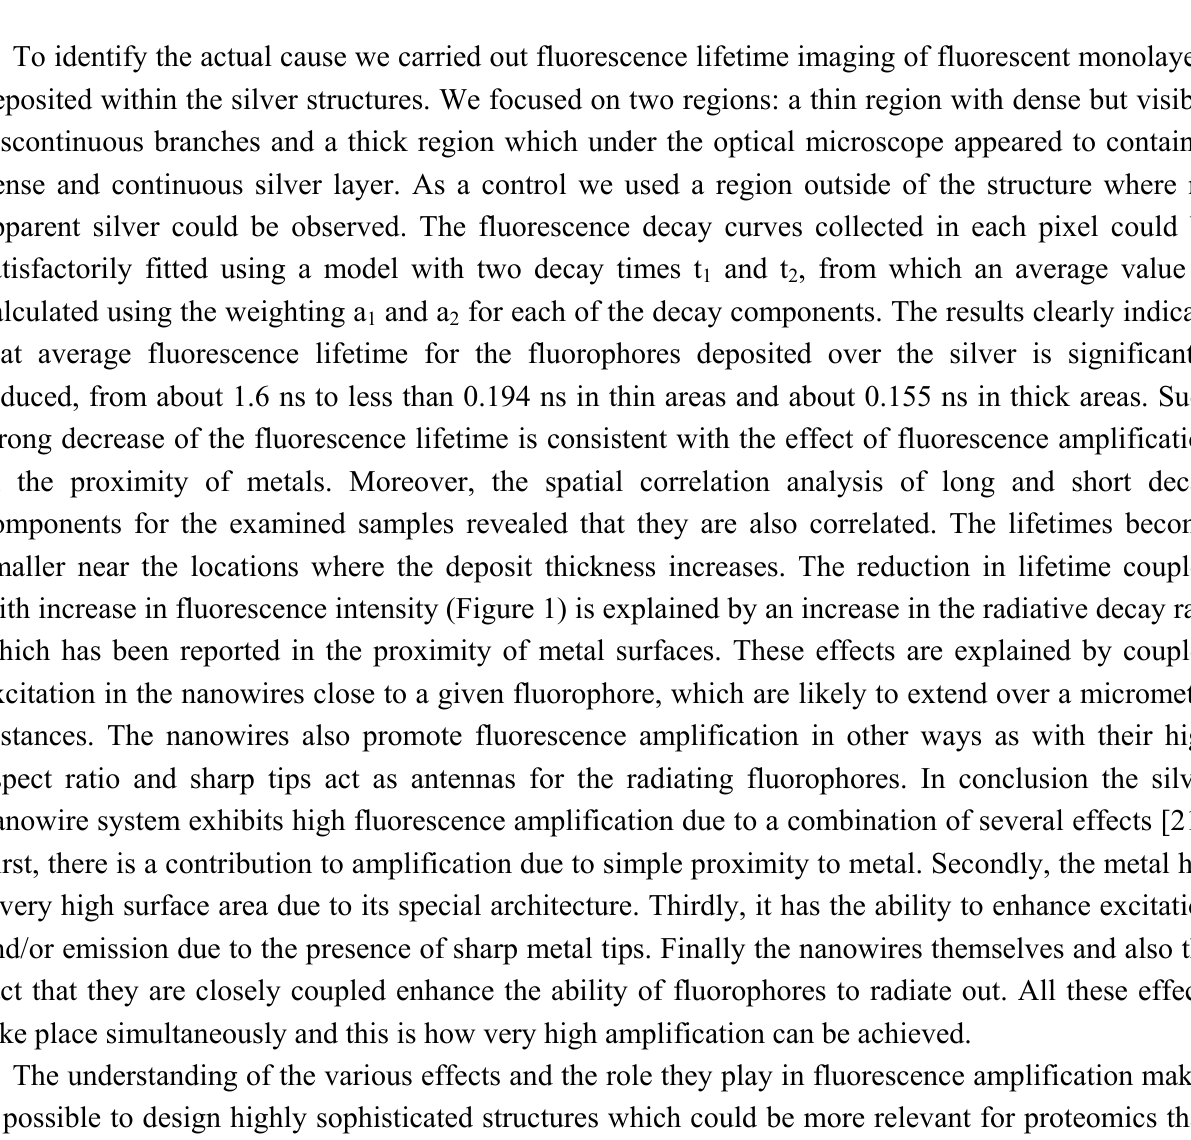
Figure 3. ESEM images of the silver structures (a) magnification x 7000, bar represents 5 um (b) magnification x 60000, bar represents 500 nm [7]. Reprint with permission from [7]. Copyright (2007) American Chemical